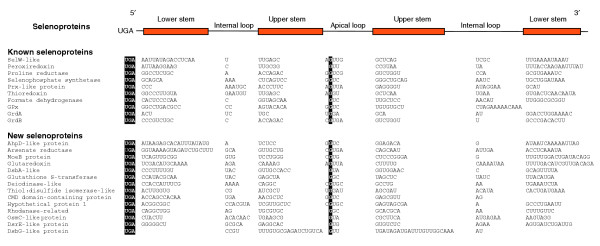
Alignment of SECIS elements present in Sargasso Sea selenoproteins. The Sargasso Sea dataset includes 10 known selenoprotein families and 15 new families. SECIS elements in representative members of these families were manually aligned on the basis of primary sequence and secondary structure features.